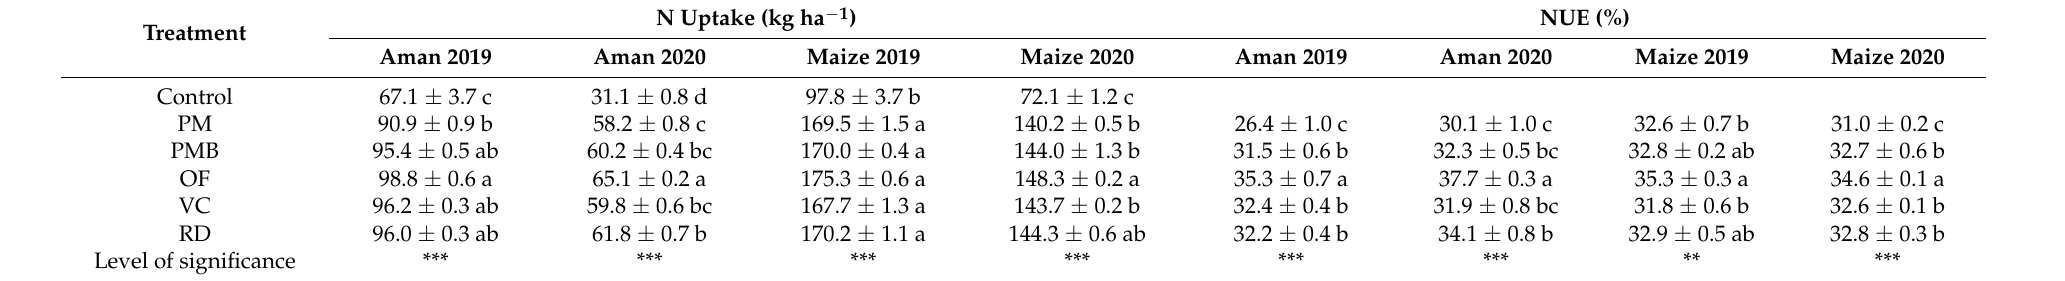
Table 10. Effects of organic amendments on N uptake and N use efficiency by T. Aman rice and maize.